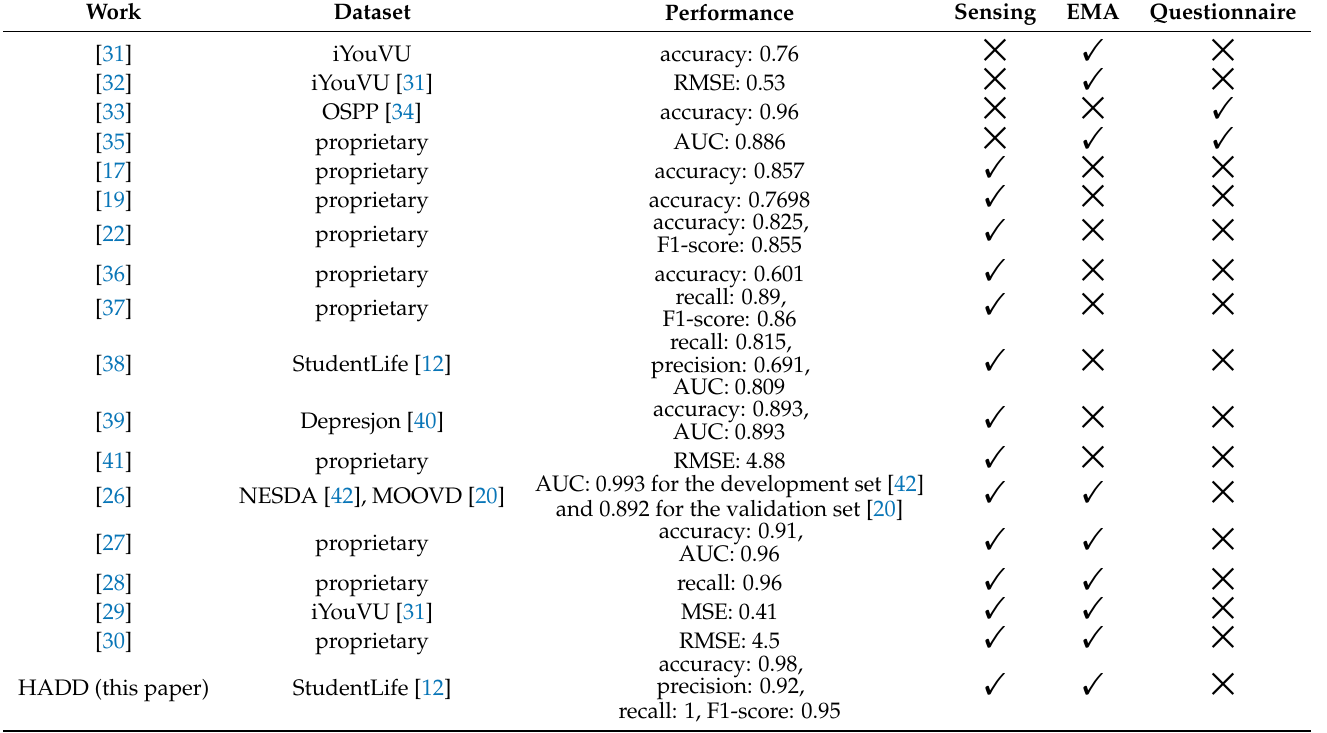
Table 1. Recent works on ML-based detection of depressed mood that are most closely related to